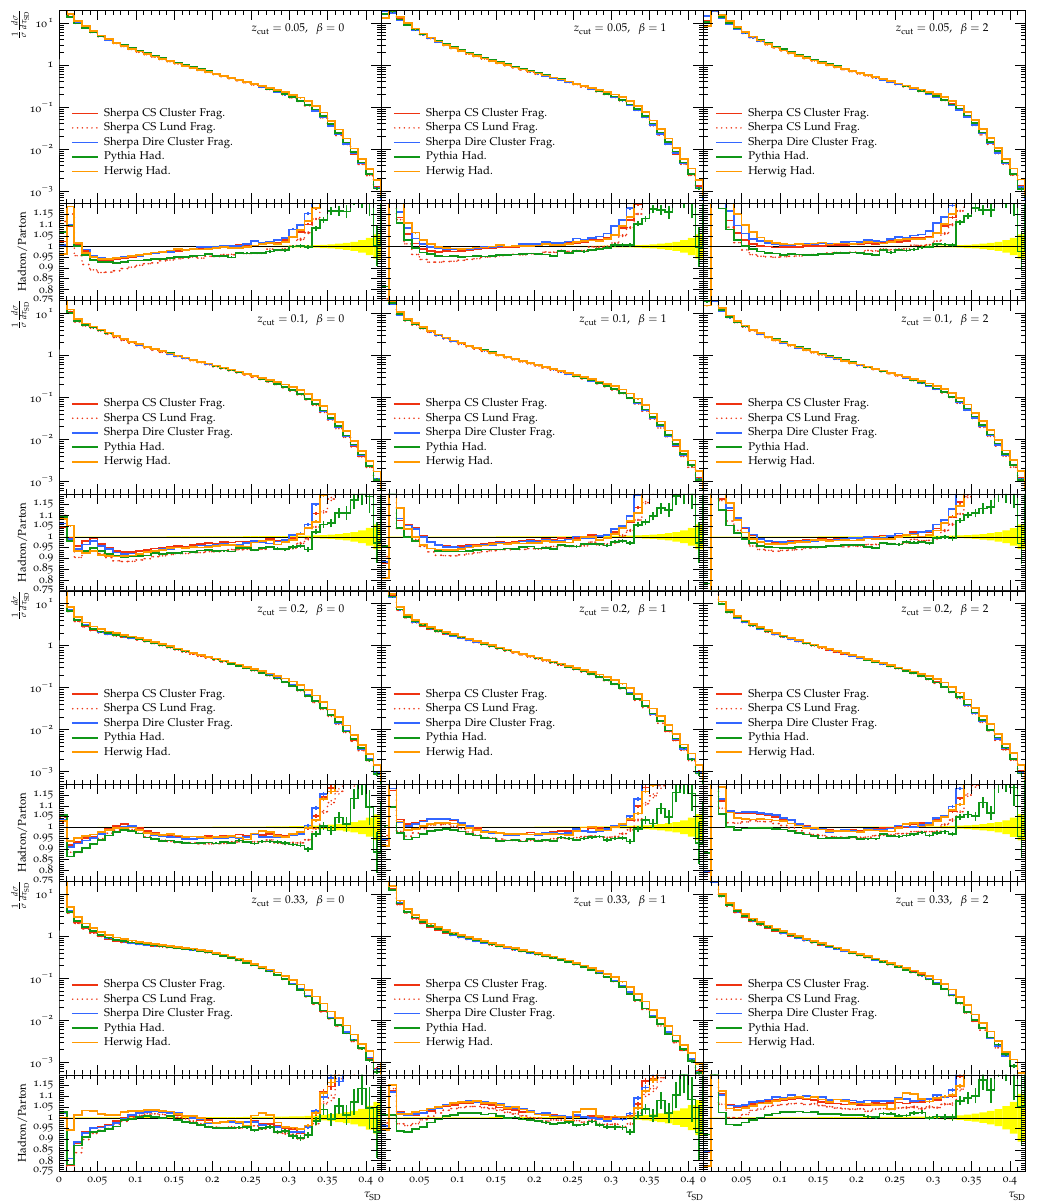
Figure 11. Predictions from general-purpose Monte Carlo generators for soft drop thrust with various z cut and (cid:12) values at parton shower accuracy. Shown are the nominal distributions at hadron level and the ratios of hadron level to the respective underlying parton level